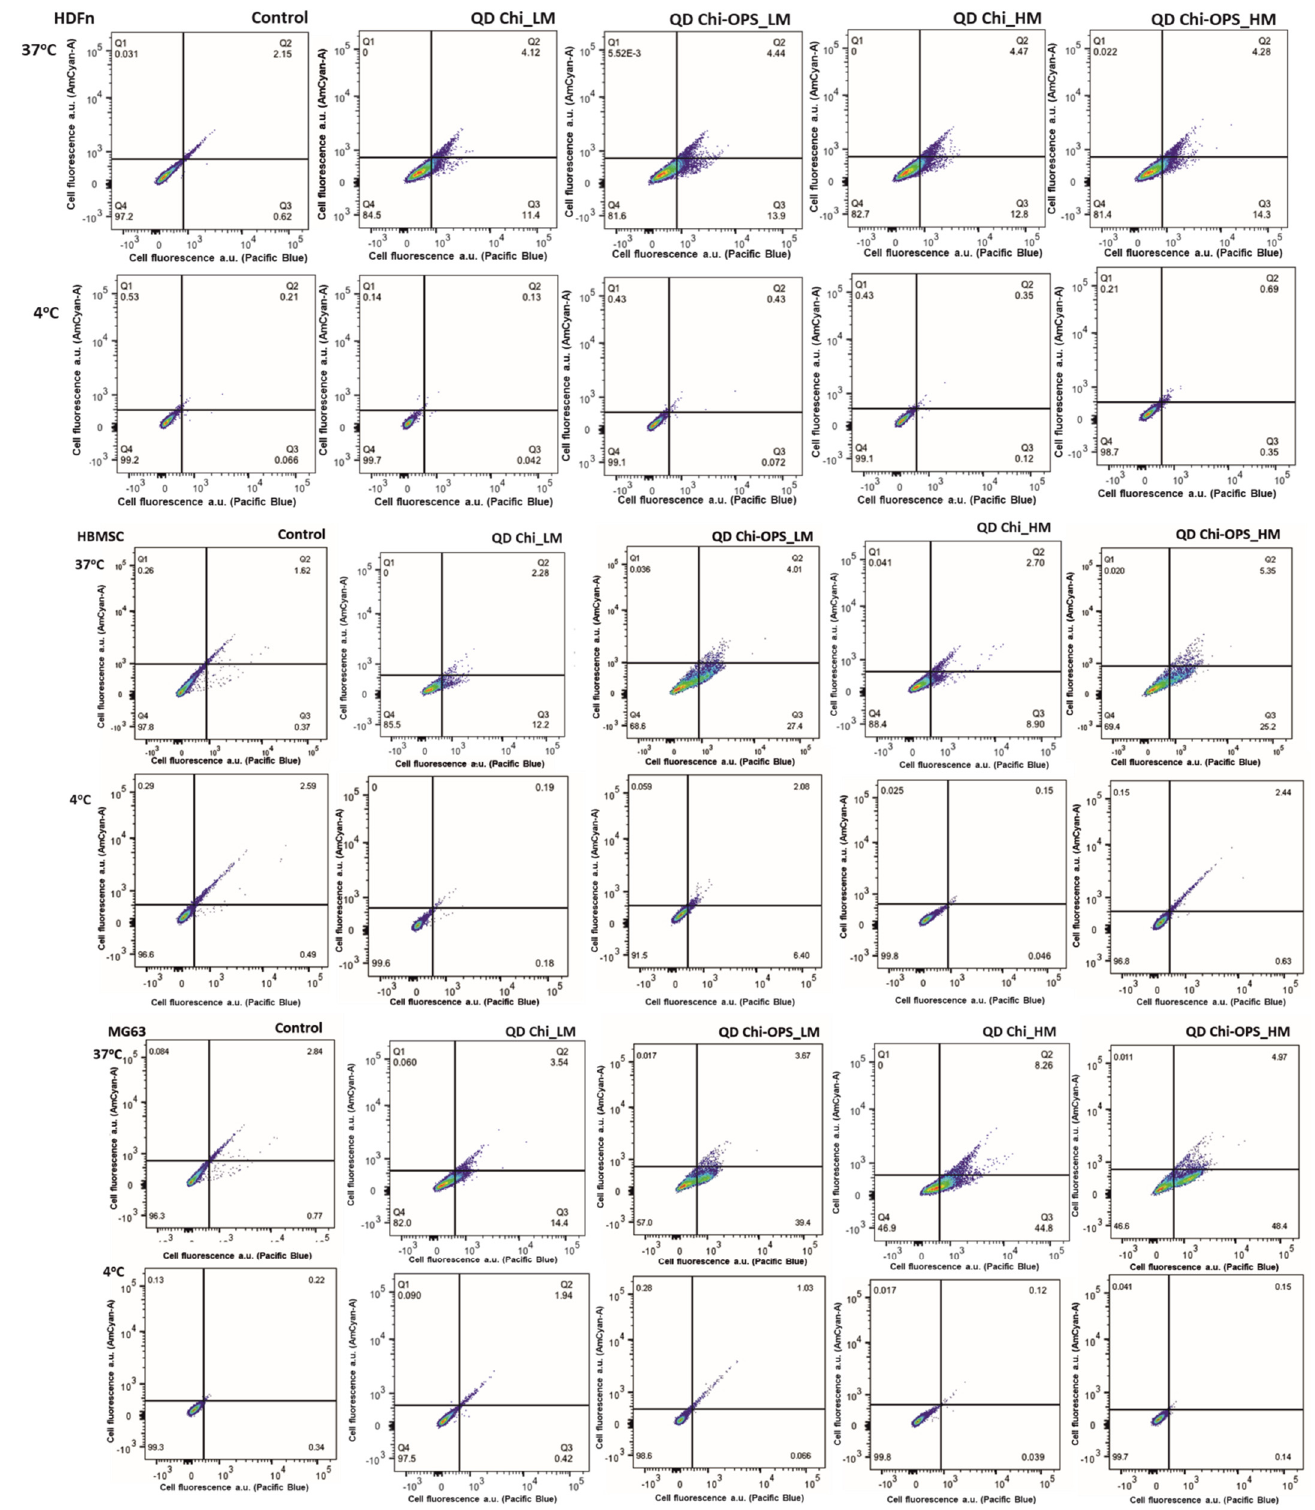
Figure 7. Quantitative flow cytometry study of endocytosis pathway (thermal effect) with different QD conjugated nanoparticles on human dermal fibroblasts (HDFn), human bone mesenchymal stromal cells (HBMSC) and human osteoblast-like cells (MG63) uptake response.